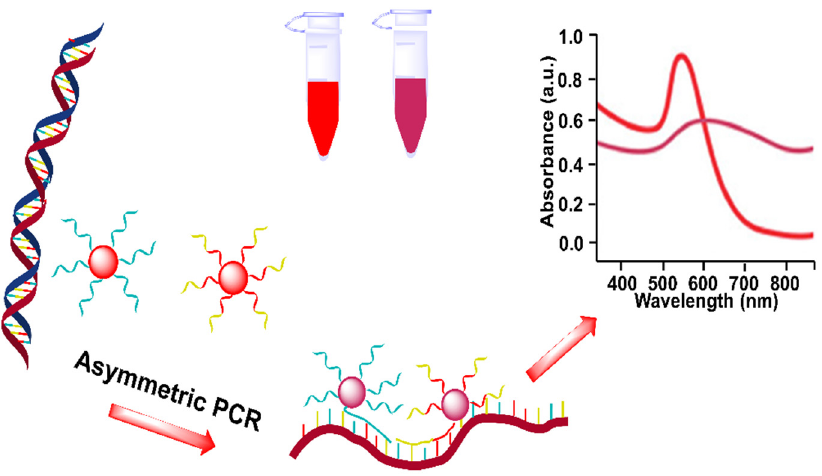
Figure 4. Schematic diagram of As-PCR product-assembled SNAs for colorimetric detection of Bacillus anthracis . Adapted with permission from ref [70]. Copyright 2012 American Chemical Society.